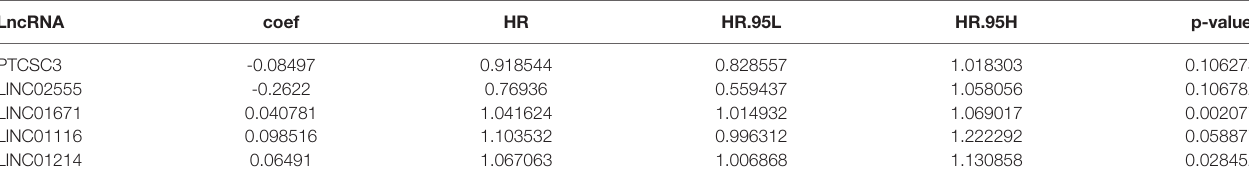
TABLE 2 | Five prognosis-related genome instability-associated lncRNAs by multivariate Cox regression analysis. LncRNA